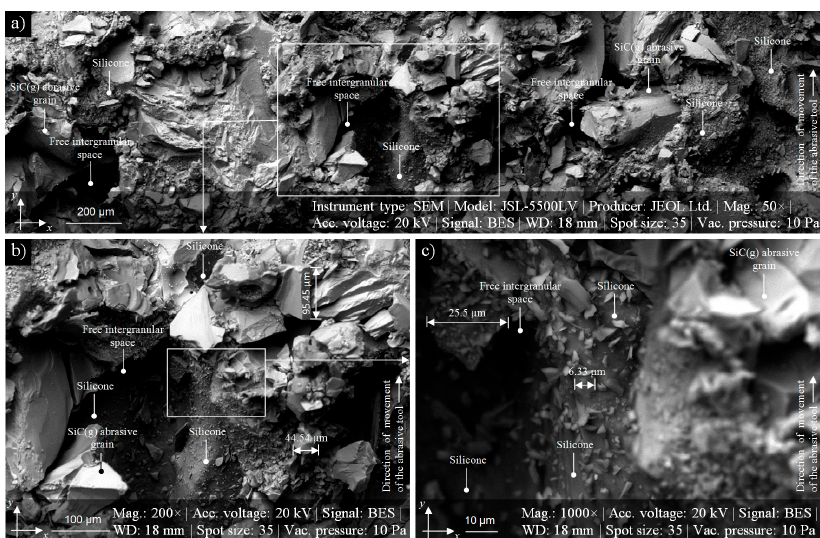
Figure 1. Collection of SEM-micrographs of silicone-treated GWAS 1-35×20×1099C46K8V before the abrasive machining process; obtained using a scanning electron microscope JEOL JSM-5500LV: SEM micrograph (area size: 2980.76 × 2236.53 μ m, magnification: 50×) presenting a fragment of vast panorama of the GWAS ( a ); SEM micrograph (area size: 662.39 × 496.58 μ m, magnification: 200×) extracted from ( a ) with visible silicon-treated areas of the GWAS ( b ); SEM micrograph (area size: 129.16 × 96.83 μ m, magnification: 1000×) extracted from ( b )—close-up of one of the silicon-treated area of the GWAS ( c ). Note: Some dimension of the abrasive grains was given in ( b ),( c ).